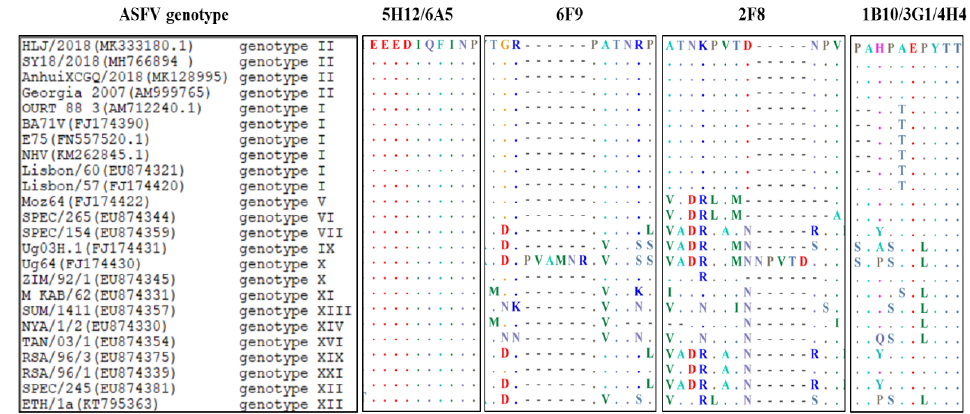
Figure 5. Sequence conservation analysis of the identified epitopes among different ASFV genotypes.